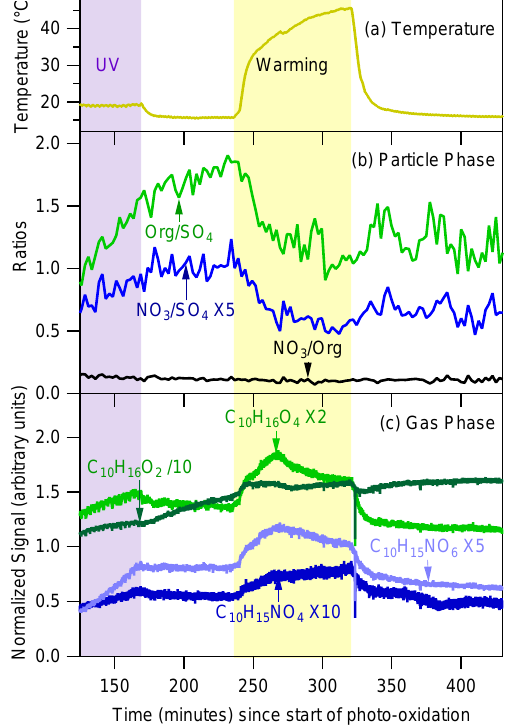
Figure 4. Temperature effects on gas–particle partitioning (Exp. 2). Organics, nitrate, and sulfate are abbreviated as Org, NO 3 , and SO 4 ,